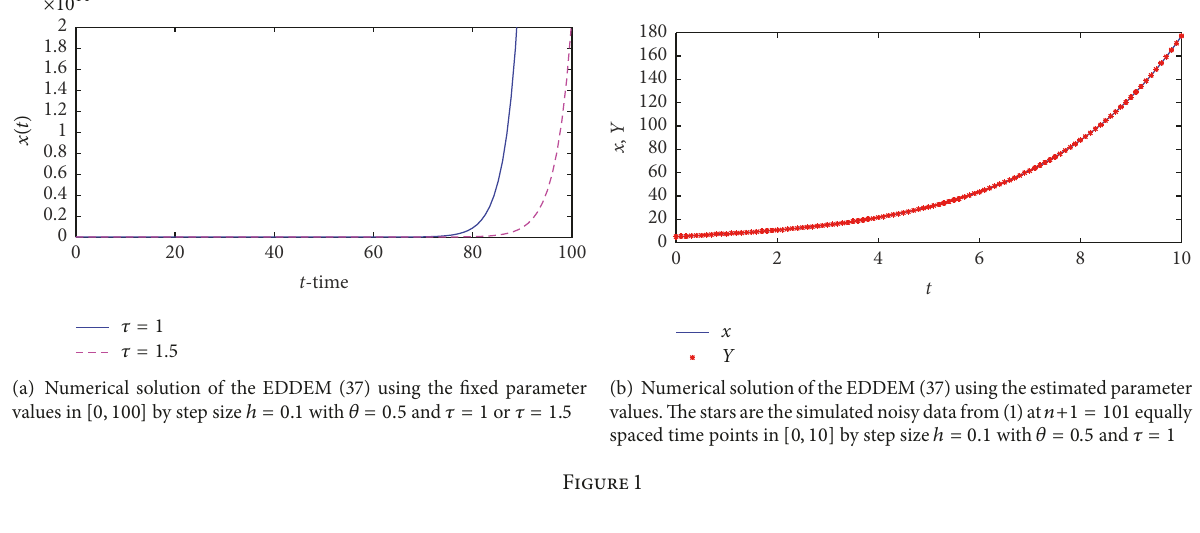
̂𝑎(̂𝜃, ̂𝜏) (̂𝜃, ̂𝜏) , , and ̂𝜎 2 for the EDDEM by using the adaptive grid procedure. Here, the number